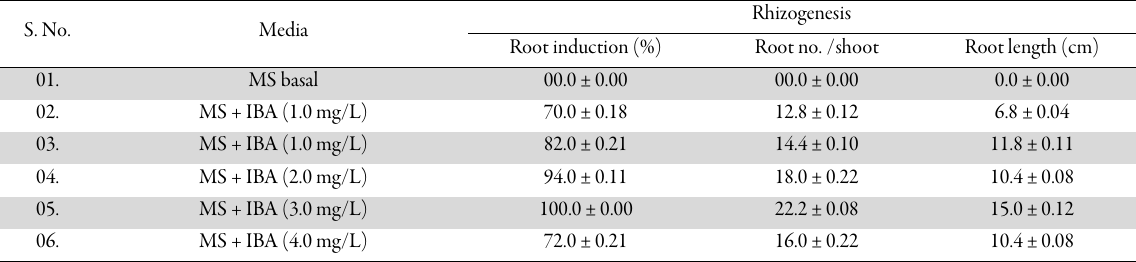
Table 3. Effect of growth regulator IBA on i n vitro rooting of Withania somnifera (L.) Dunal S.